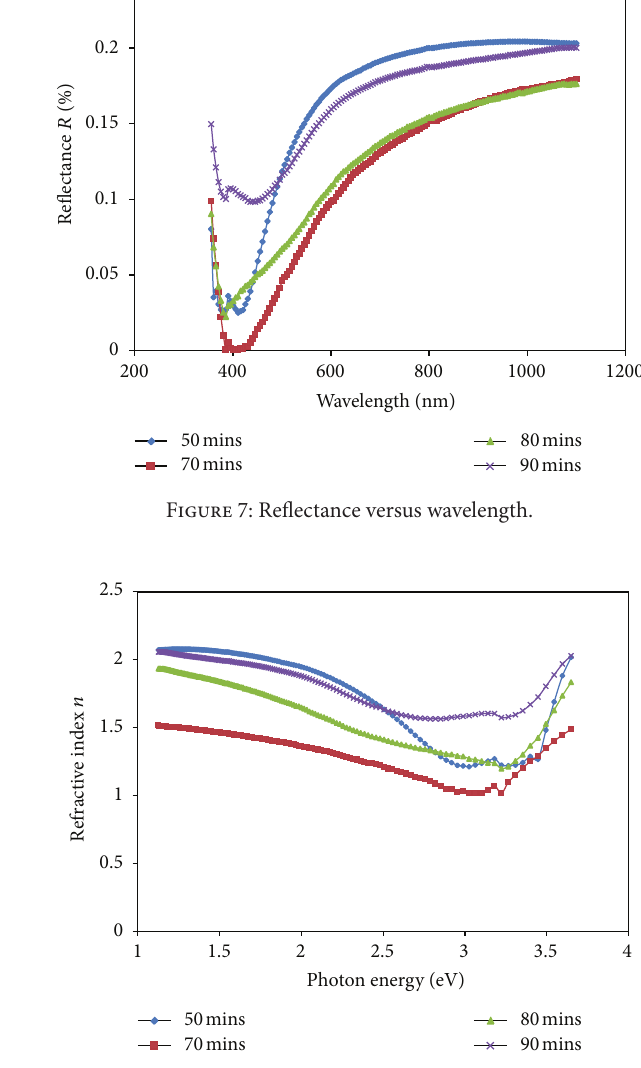
Figure 8: Refractive Index 𝑛 against photon